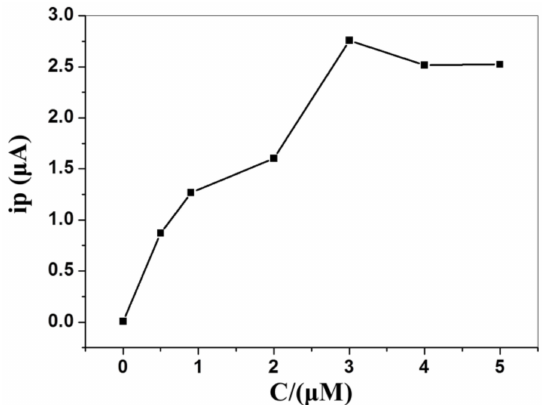
Figure 4. The relationship between the concentration of the aptamer probe and the peak current under the reaction with 5.0 × 10 2 CFU/mL E. coli .